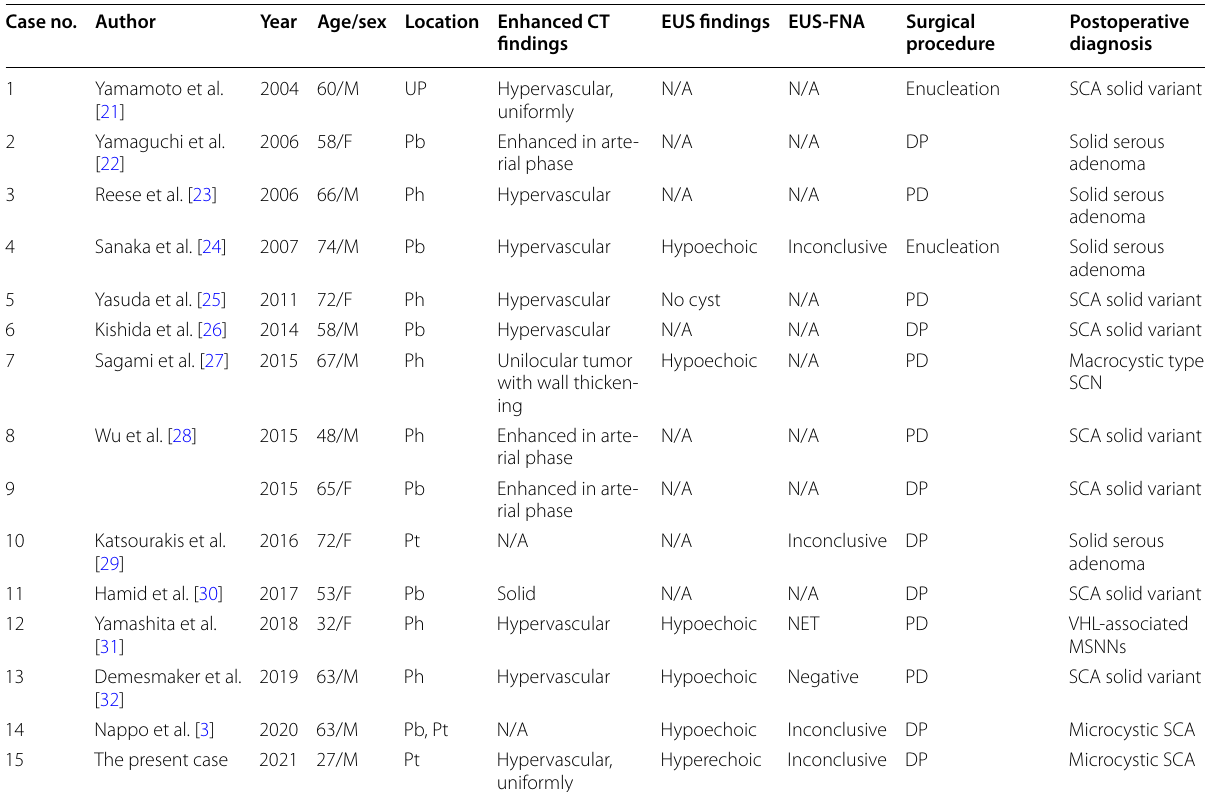
EUS-FNA: endoscopic ultrasound-fine needle aspiration; UP: uncinate process of the pancreas; Ph: pancreatic head; Pb: pancreatic body; Pt: pancreatic tail; DP: distal pancreatectomy; PD: pancreaticoduodenectomy; SCA: serous cystadenoma; SCN: serous cyst neoplasm; VHL-associated MSNNs: Von Hippel–Lindau-associated mixed serous neuroendocrine neoplasms; N/A: not applicable